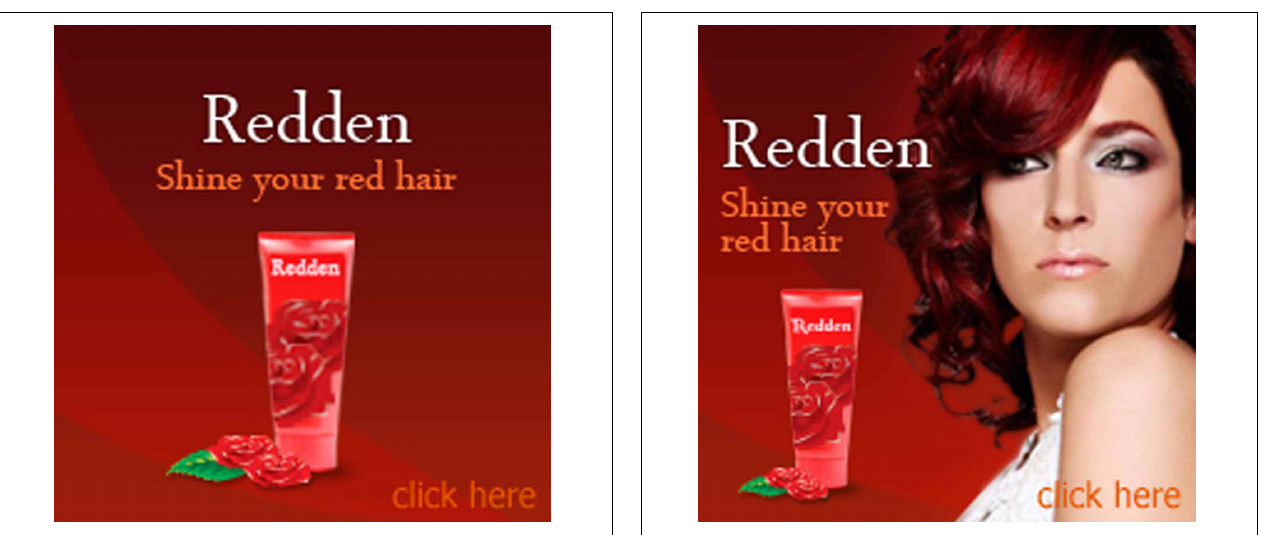
FIGURE 3 | Fabricated vertical banner advertisement for “Redden” in the no face condition.